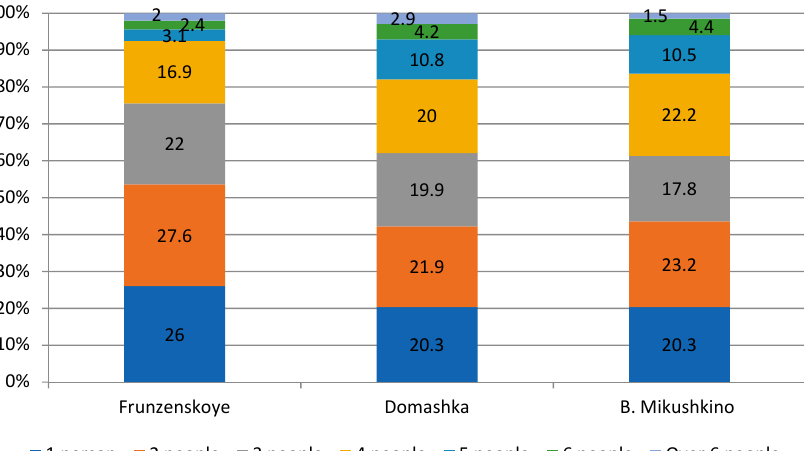
Figure 13. Comparison of private household plots by their quantitative composition in 2014–2018.